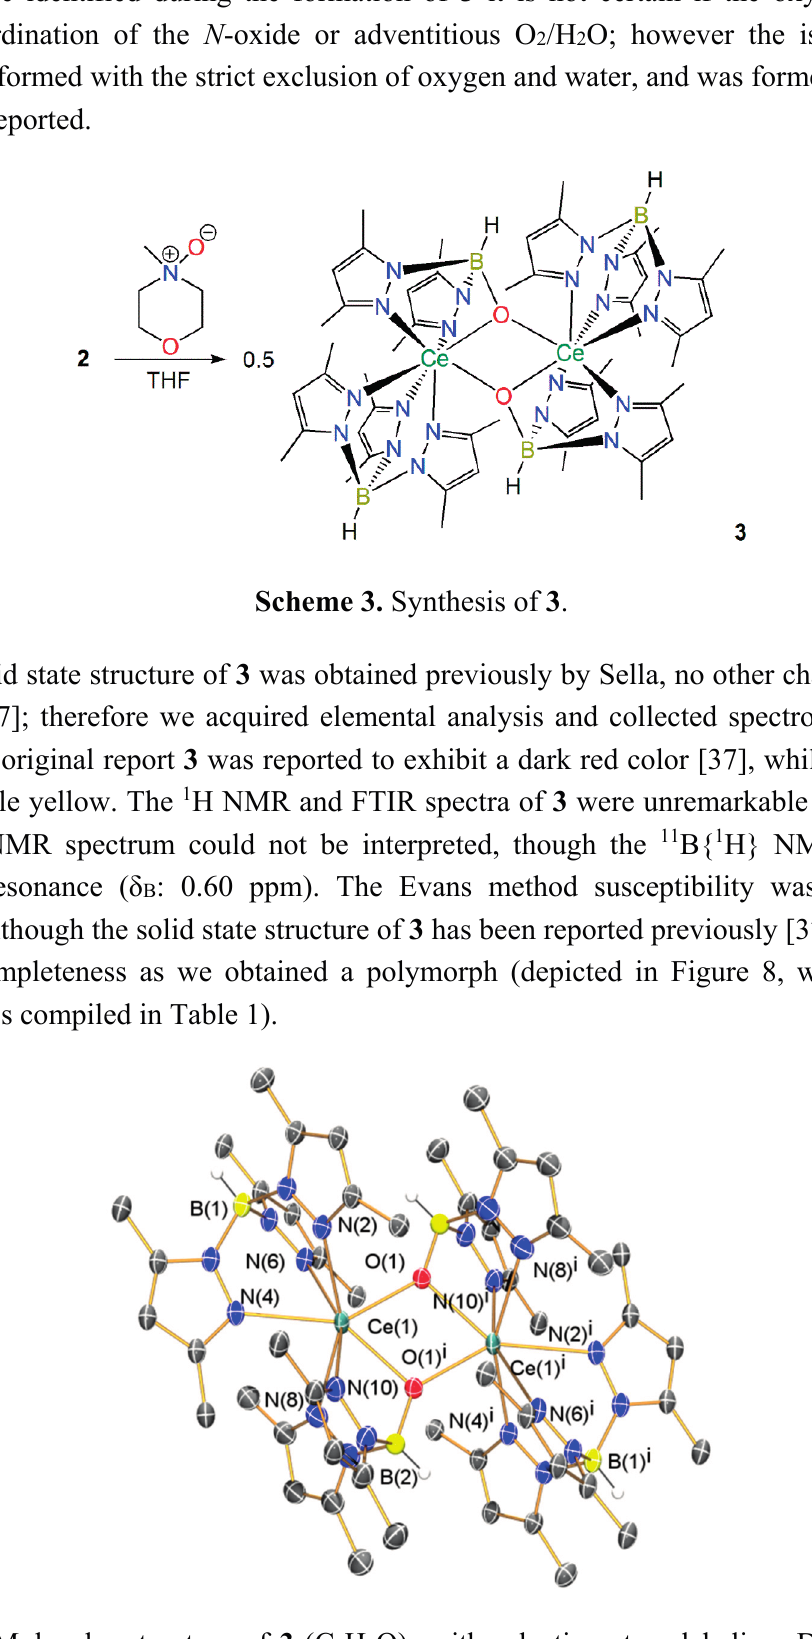
Figure 8. Molecular structure of 3 ·(C 4 H 8 O) 2 with selective atom labeling. Displacement ellipsoids set at 30% probability level and hydrogen atoms (except B–H) and lattice solvent omitted for clarity. Symmetry operation to generate equivalent atoms: i = 1 − x , 1 − y , 1 − z